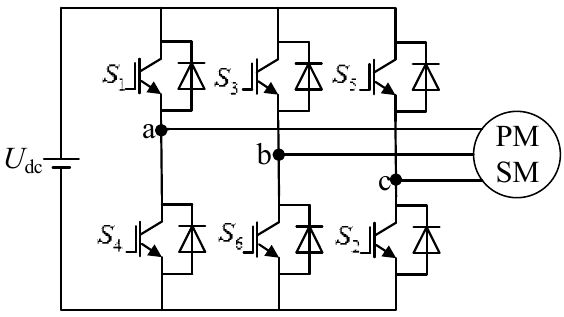
Figure 1. The main circuit of the permanent magnet synchronous motor (PMSM) drive.